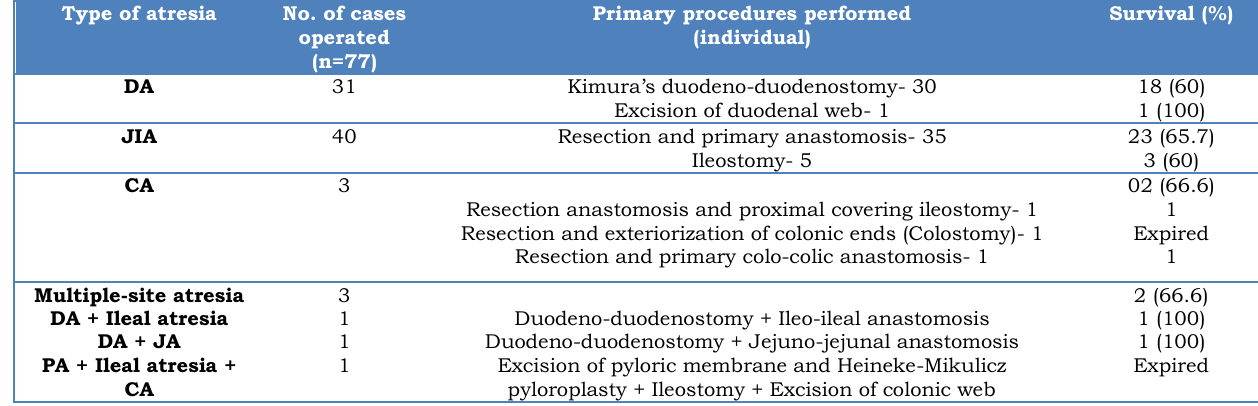
Table 1: Type of atresia, management and survival (%) in current study Type of atresia